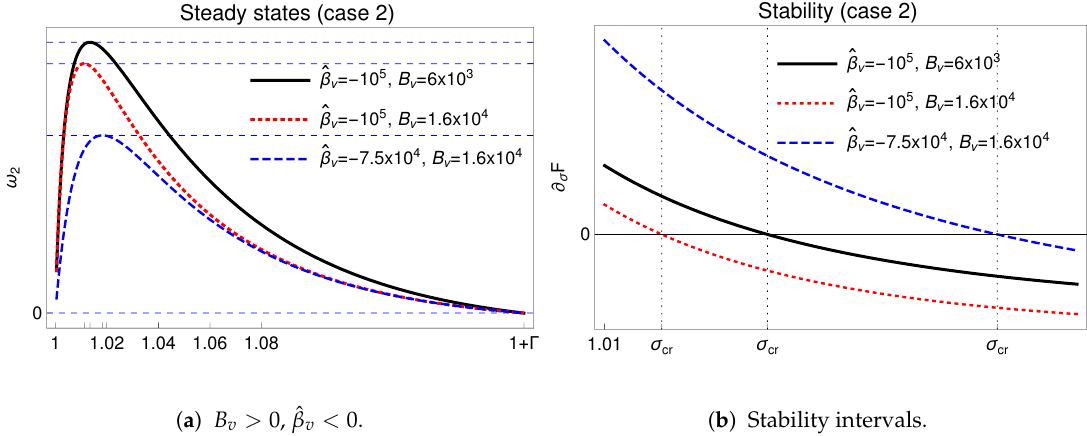
Figure 4. ( a ) Steady statesfor T o = 1.0005, two negative values of ˆ β v and two positive values of B v . ( b ) For ˆ β v = − 10 5 and B v = 10 5 , the critical values σ cr and ω cr are, respectively, ≈ 1.01345 and ≈ 9 × 10 − 5 . For ˆ β v = − × 10 5 and B v = 1.6 × 10 4 , the critical values σ cr and ω cr are, respectively, ≈ 1.011 and ≈ 8.3 × 10 − 5 . For ˆ β v = − 7.5 × 10 4 and B v = 1.6 × 10 4 , the critical values σ cr and ω cr are, respectively, ≈ 1.018 and 6 × 10 − 5 . All steady states for σ > σ cr and ω 2 < ω 2,cr are stable. In dimensional variables, these values correspond, respectively, to the critical interface being located at − 1185 m, − 1154 m and − 1252